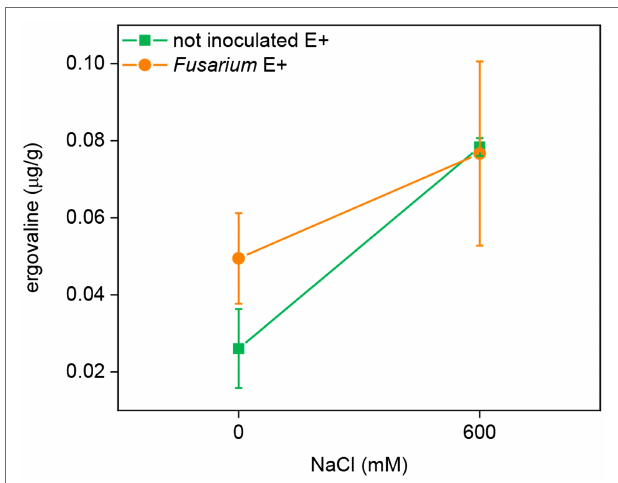
FIGURE 6 | Ergovaline concentration in leaves of FRP line EB15 symbiotic with E. festucae (E + ), inoculated with F. oxysporum T48 (orange) or uninoculated (green), and subjected to two different salinity treatments (0 and 600 mM